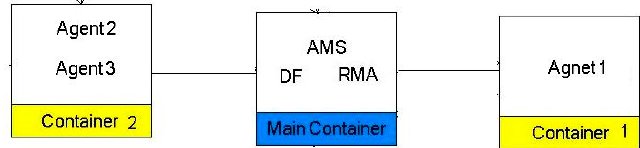
Figure 8. Java Agent Development Framework (JADE) container and platform.